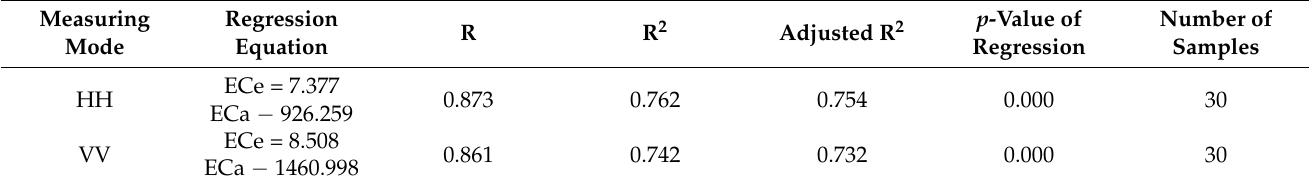
Table 7. Equations for ECe estimation of HH and VV modes using